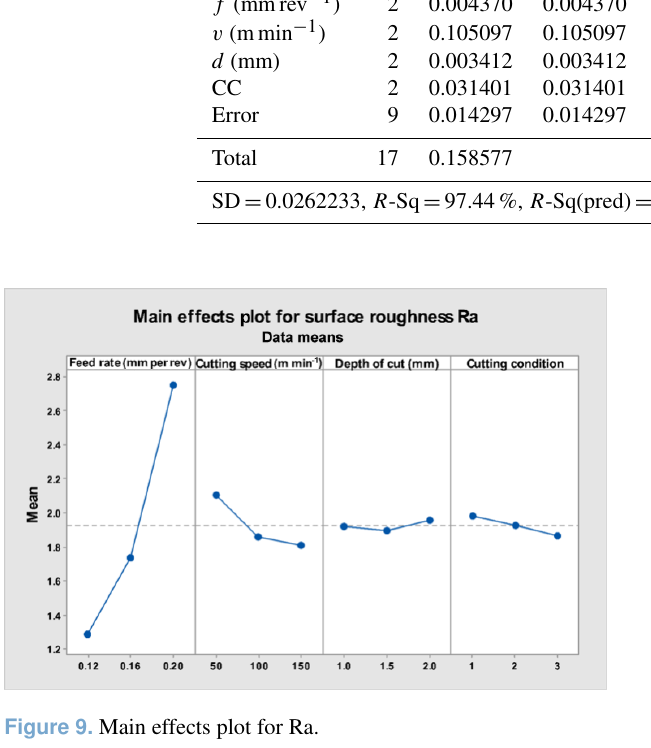
Figure 9. Main effects plot for